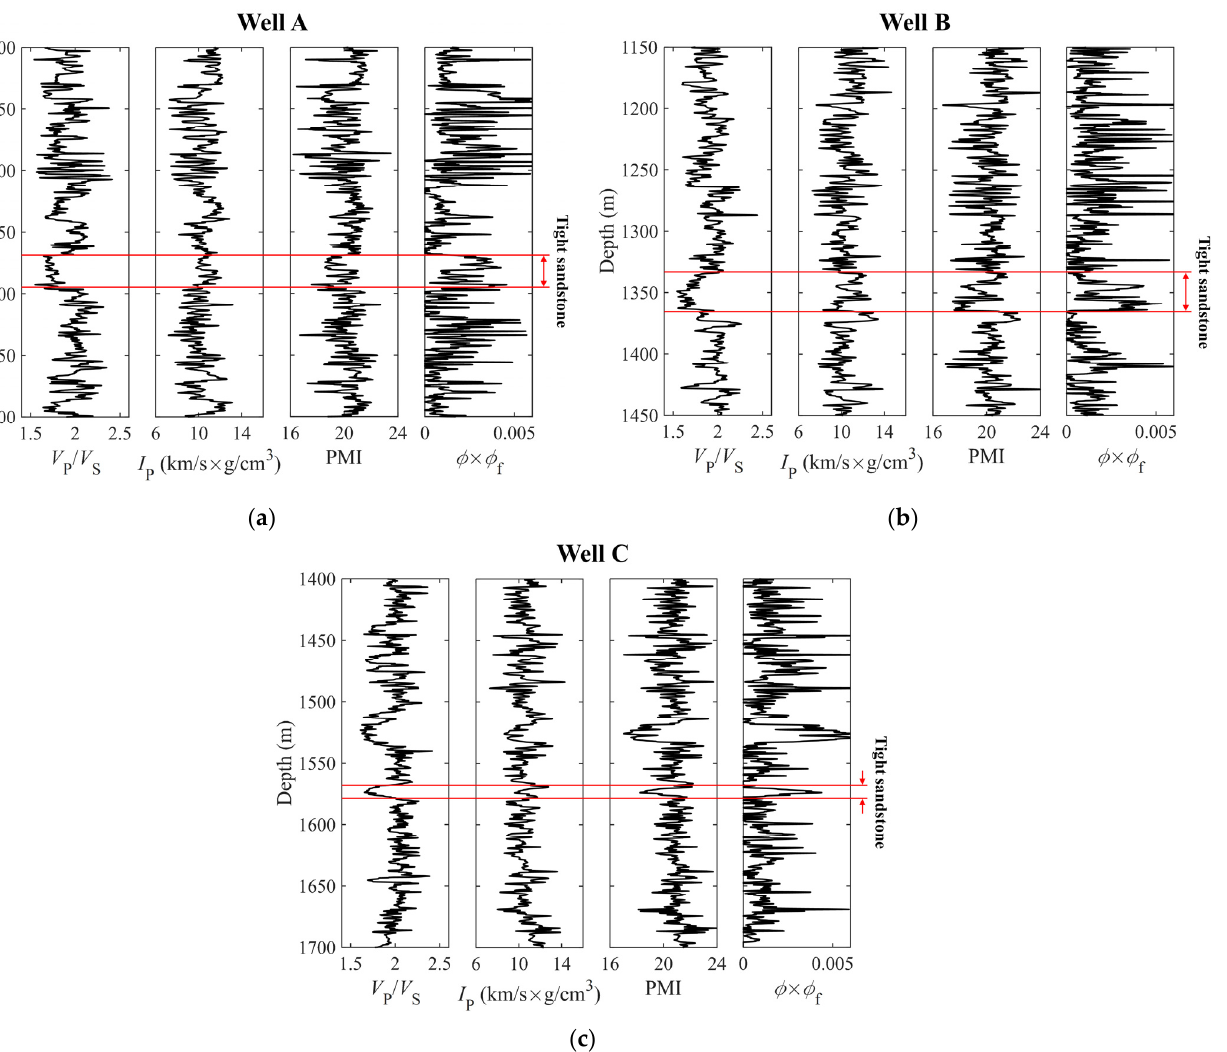
Figure 7. The plots of V P / V S , I P , PMI at θ max = 101°, and ϕ × ϕ f for ( a ) well A, ( b ) well B, and ( c ) well C.